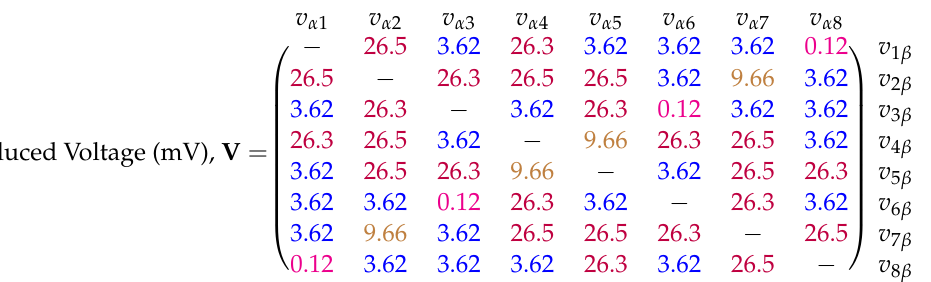
Figure 5. Simulated mutual inductance matrix for the eight coil PCB transmitter of the Anser EMT system. The entries have units of microhenries (µH). Self-inductances of each coil are omitted. Precision of entries have been truncated with similar values colour-coded for clarity. Each coil area was subdivided into 4 million area elements for the integration process.